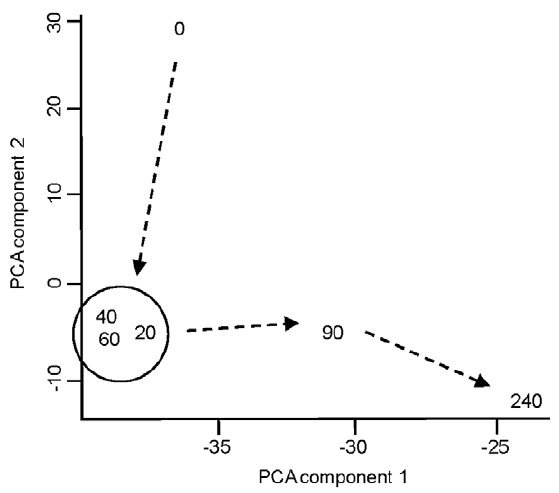
Figure 2. Principal component analysis (PCA) of meningococcal transcriptomes obtained at different blood co-cultivation time points. The numbers in the plot represent the relative positions of samples and co-cultivation time points. Dashed arrows represent the